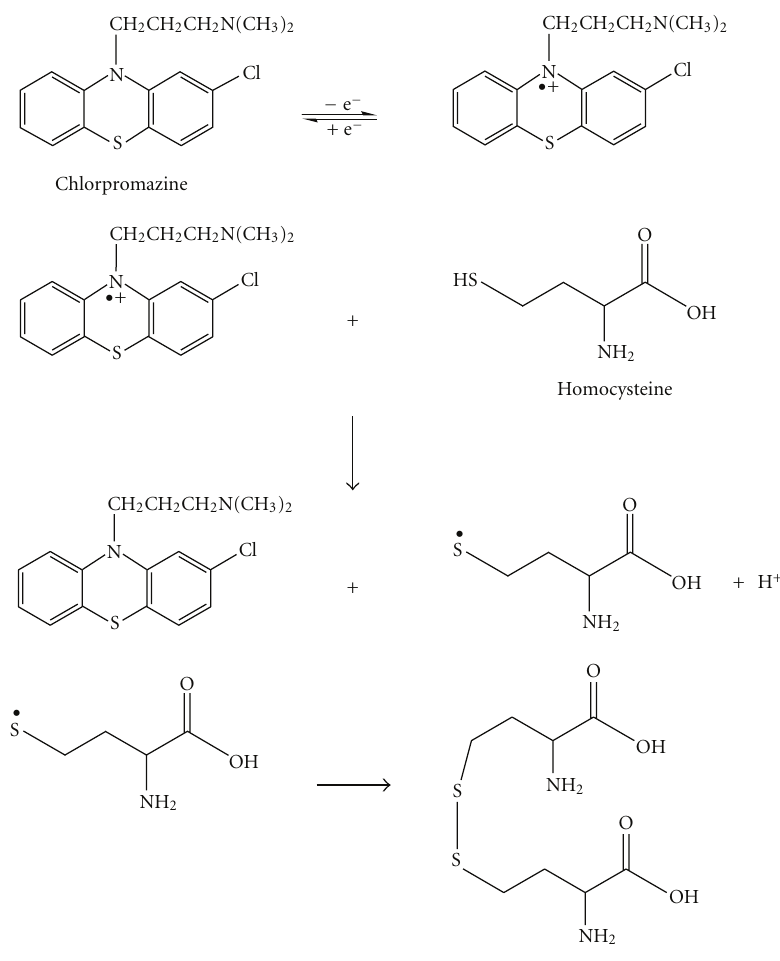
Scheme 1: The role of chlorpromazine on the oxidation of Hcy. Table 2: Comparison of the e ffi ciency of some electrochemical methods in the determination of Hcy. Electrode